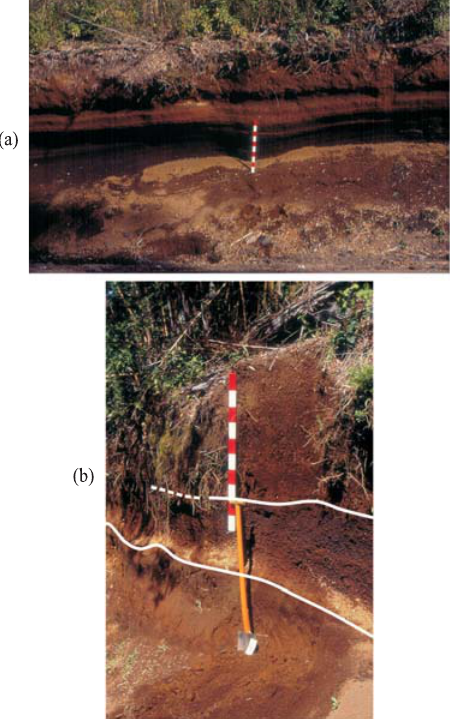
Figura 9. (a) Depósitos piroclásticos nas encostas do Vulcão Villarica, sul do Chile; (b) Perfis de solo desenvolvidos a partir de três depósitos de cinzas vulcânicas no Vulcão Villarica. As linhas brancas indicam as paleosuperfícies (além da atual) onde se desenvolvem os solos. Pelo fato de os depósitos serem muito recentes, tratam-se de solos enterrados e não